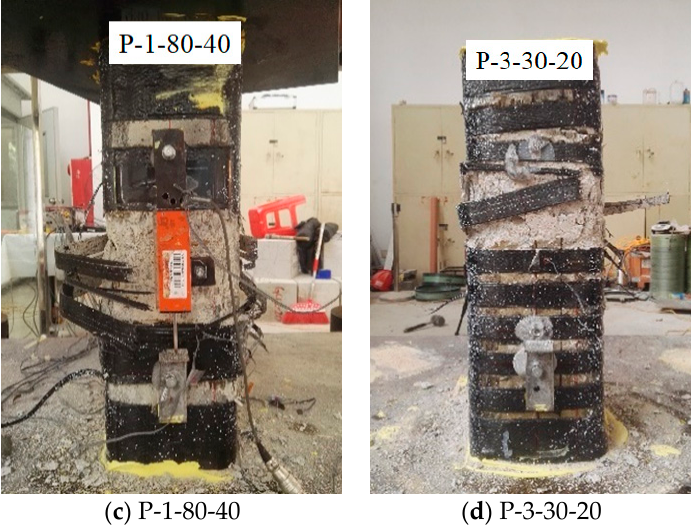
Figure 6. Typical failure modes of selected specimens.